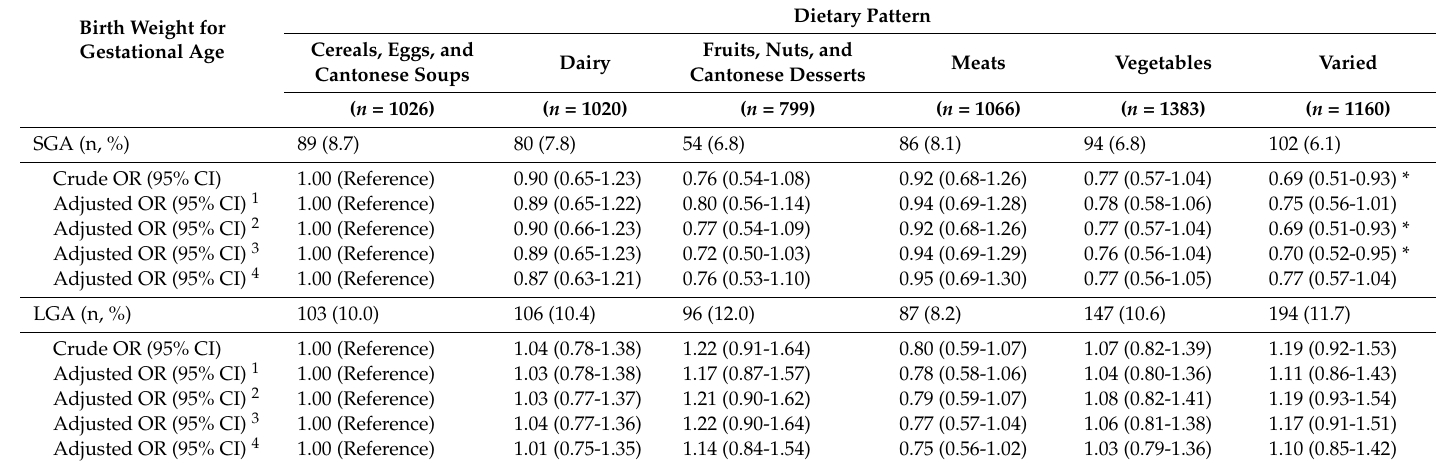
Table 4. Odds ratios (ORs) and 95% confidence intervals (95% CIs) of birth weight for gestational age to six dietary patterns identified among 6954 pregnant women from the Born in Guangzhou Cohort Study. SGA refers to small-for-gestational age; LGA refers to large-for-gestational age. Dietary Pattern Birth Weight for Cereals, Eggs, and Fruits, Nuts, and Gestational Age Dairy Cantonese Soups Cantonese